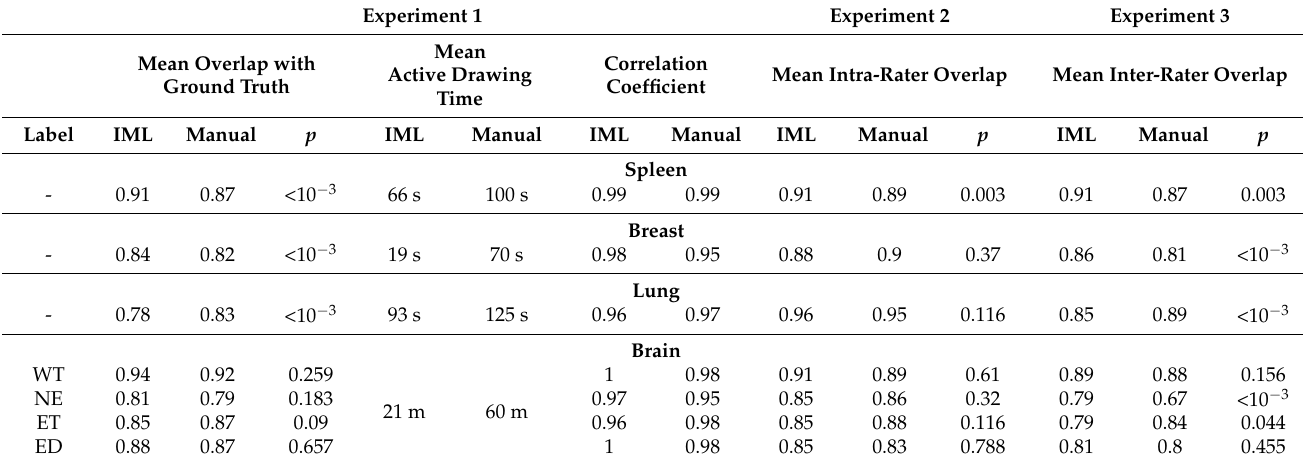
Table 1. Results for all three experiments. Experiment 1: Overlap is calculated as dice coefficient relative to ground truth. p -values are the result of paired comparisons between the highest scoring interactive ML-assisted and manual segmentations for each rater and each case. Correlation coefficient is calculated between the resultant and ground truth volumes. Experiment 2: Values indicate overlap between the first and second cycle of each rater. p < 0.05 indicates a significant difference between the results of interactive ML and manual segmentations. Experiment 3: Values indicate overlap between segmentations of different raters. p < 0.05 indicates a significant difference in the inter-rater results for the respective cohort.